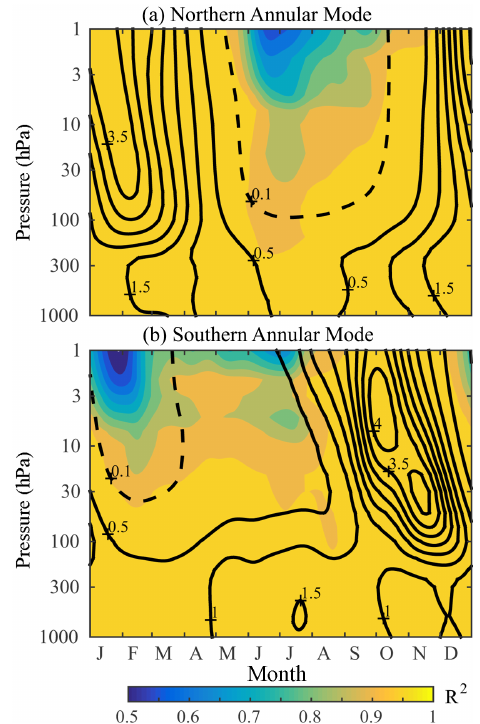
Figure 4. Consistency of (a) the Northern and (b) Southern Annular Mode indices in the modern reanalyses, as a function of pressure and the time of year, for the period 1981 to 2010. Consistency was quantified by the average pairwise R 2 correlation between ERA- Interim, JRA-55, MERRA2, and CFSR and indicated by the color shading. Contours indicate the variance of the REM annular mode, which has been normalized to have unit variance in the annual mean at each level; the interval is 0.5 units of variance, with an additional dashed contour at